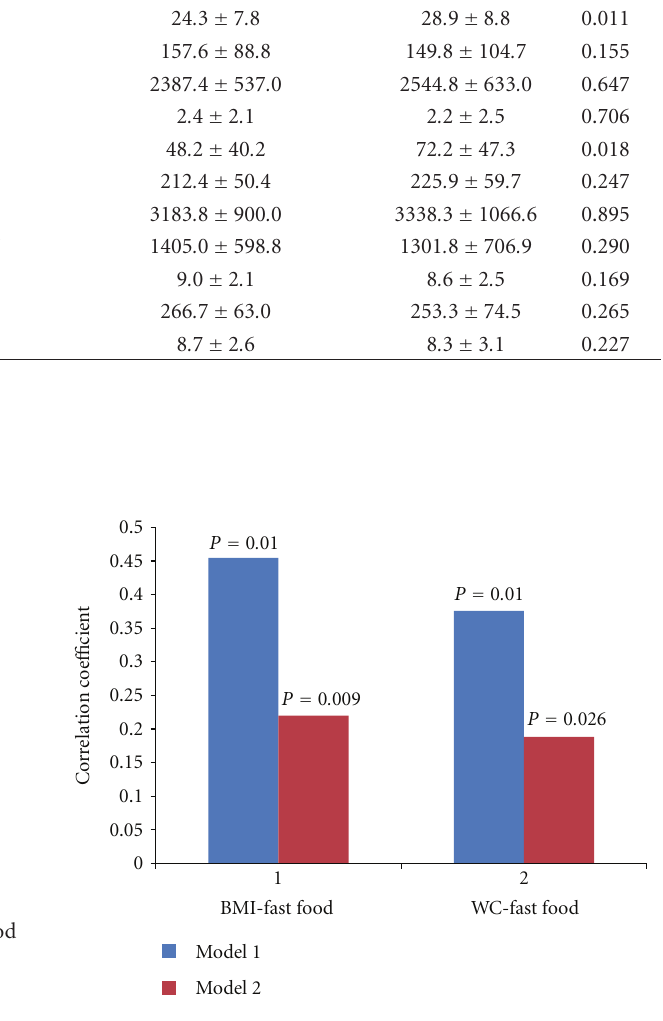
Figure 2: Correlation coe ffi cients between BMI, waist circumfer- ence, and fast food consumption. Model 1: crude model, Model 2: energy-adjusted